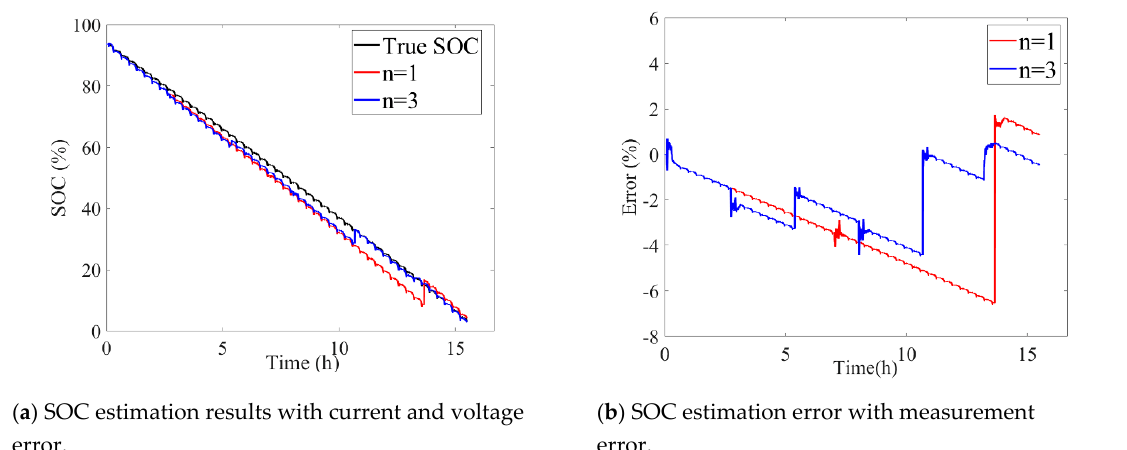
Figure 9. SOC estimation with voltage drift of +6 mV and current drift of − 8% under different transition conditions.